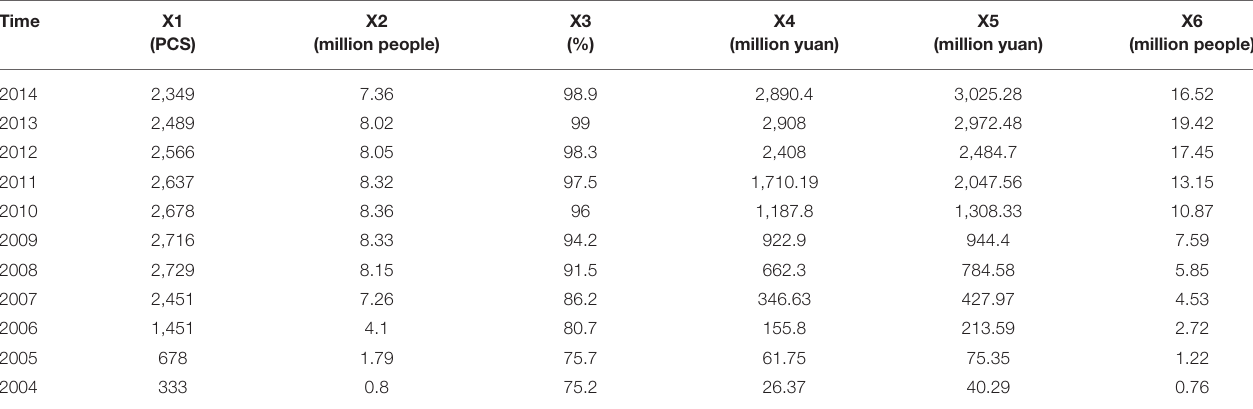
TABLE 1 | Descriptive statistics of raw